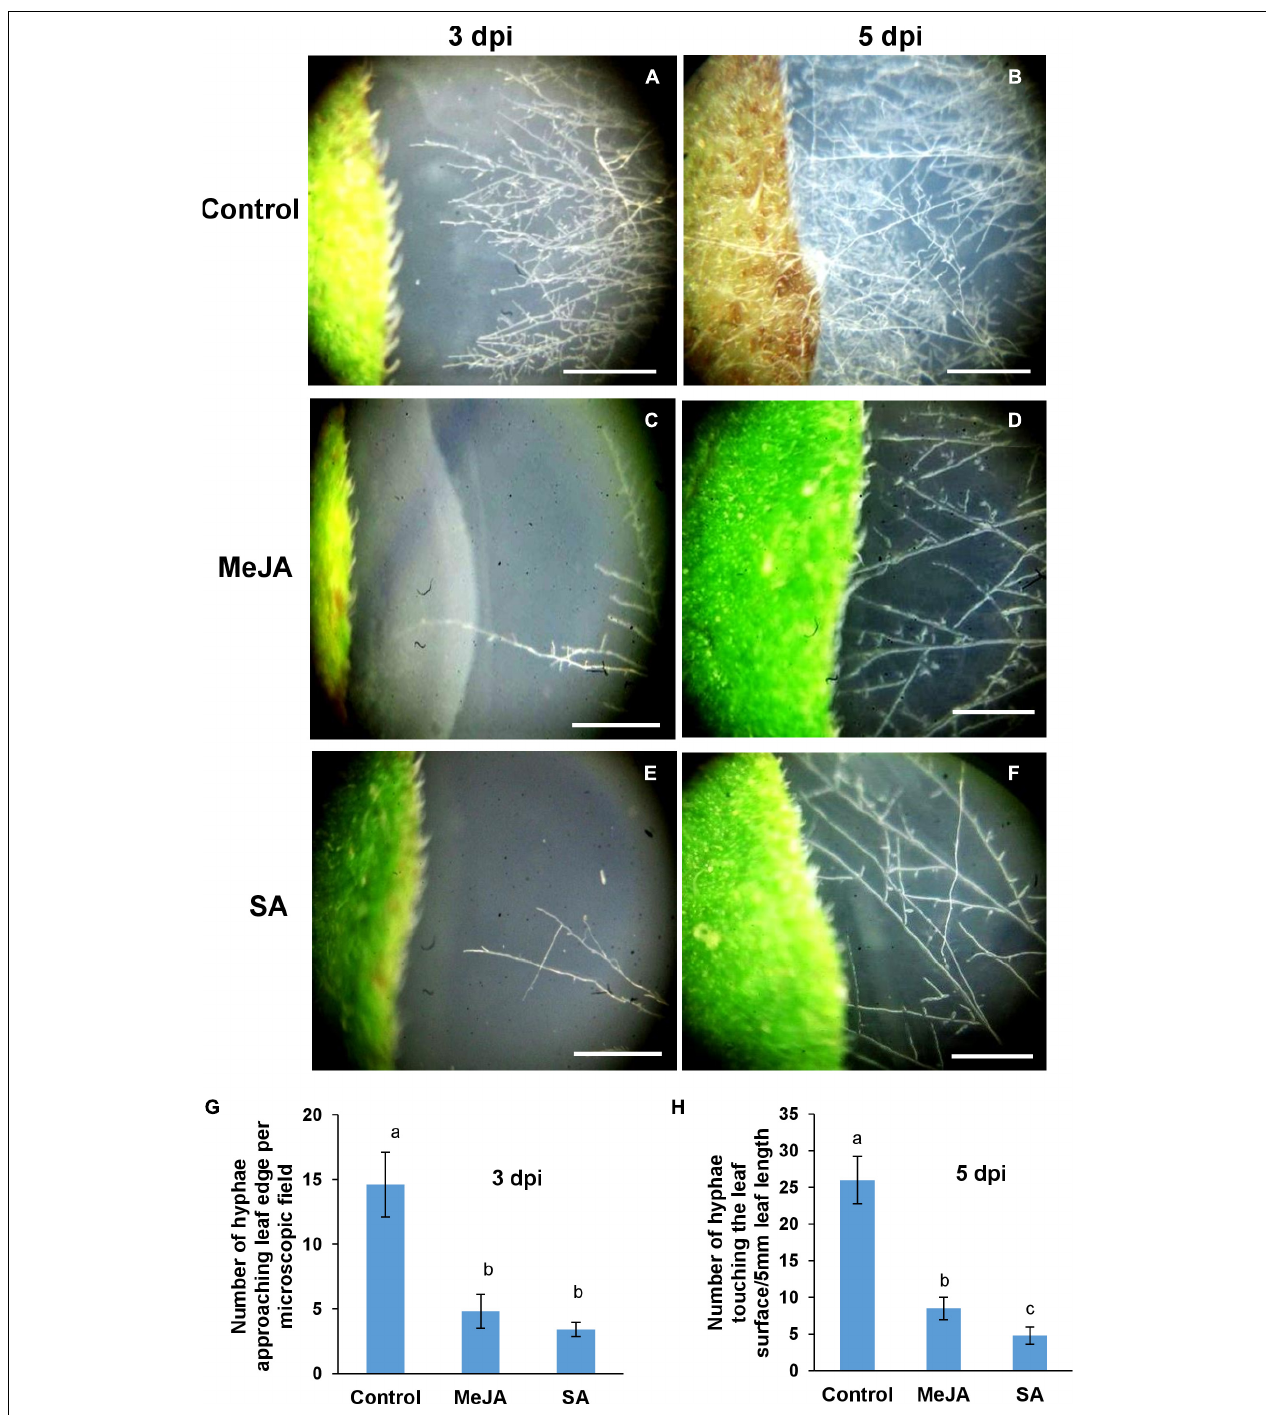
FIGURE 1 | Differential behavior of Rhizoctonia solani hyphae in the vicinity of phytohormone primed and control leaves. (A,B) When allowed to approach the host leaves from a distance, R. solani hyphae showed more preference for the control leaves with more number of hyphae per unit area in the vicinity of the leaves. (C,D) The number of hyphae approaching and making contact with the edge of the leaf was significantly less in the case of the methyl jasmonate (MeJA)-primed leaves. (E,F) Least number of hyphae approached the salicylic acid (SA)-primed leaves where the hyphae grew parallel to the leaf edge, avoiding perpendicular contact. (G) Graph showing hyphal density in the vicinity of leaves at 3 dpi. (H) Graph showing number of hyphae making contact with the edge of the leaves at 5 dpi, with control showing maximum hyphae followed by MeJA-primed leaves and least in the SA-primed leaves. Bars represent mean ± S.E.M of three independent experiments with three replicates. Different letters indicate significant differences among treatments at p < 0.05 according to Duncan’s multiple range test. Bar = 2 mm.